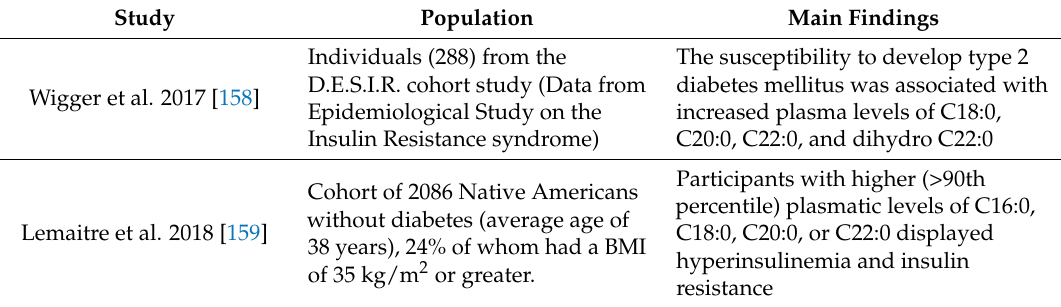
Table 3. Plasma levels of ceramide and insulin